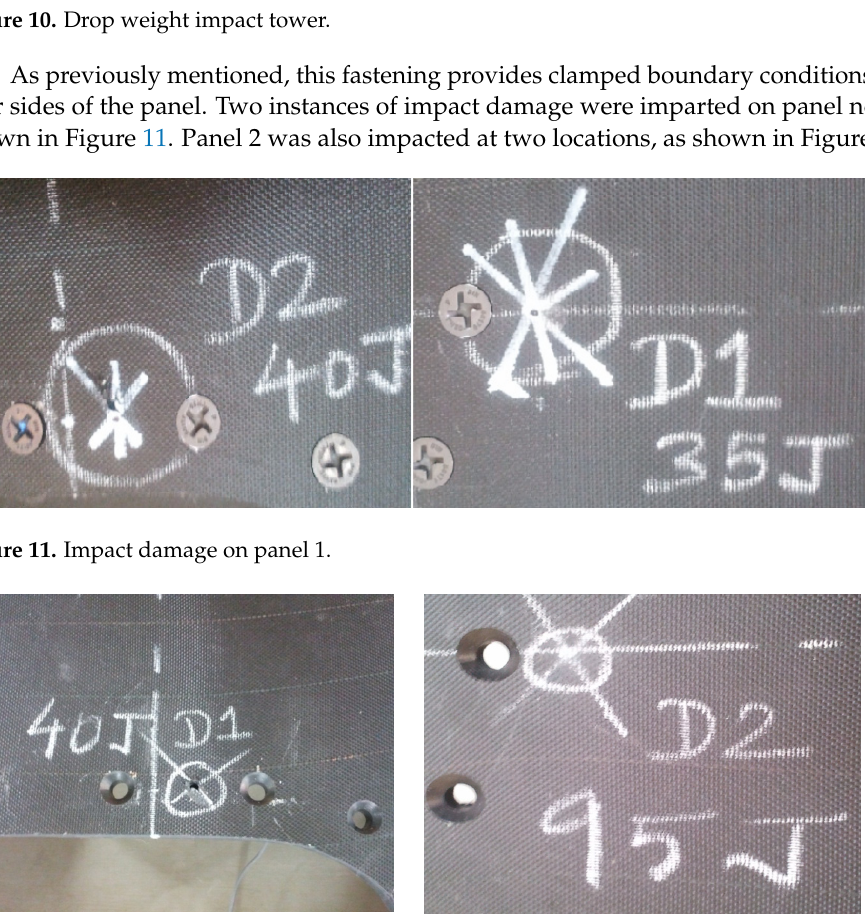
Figure 12. Impact damage on panel 2.